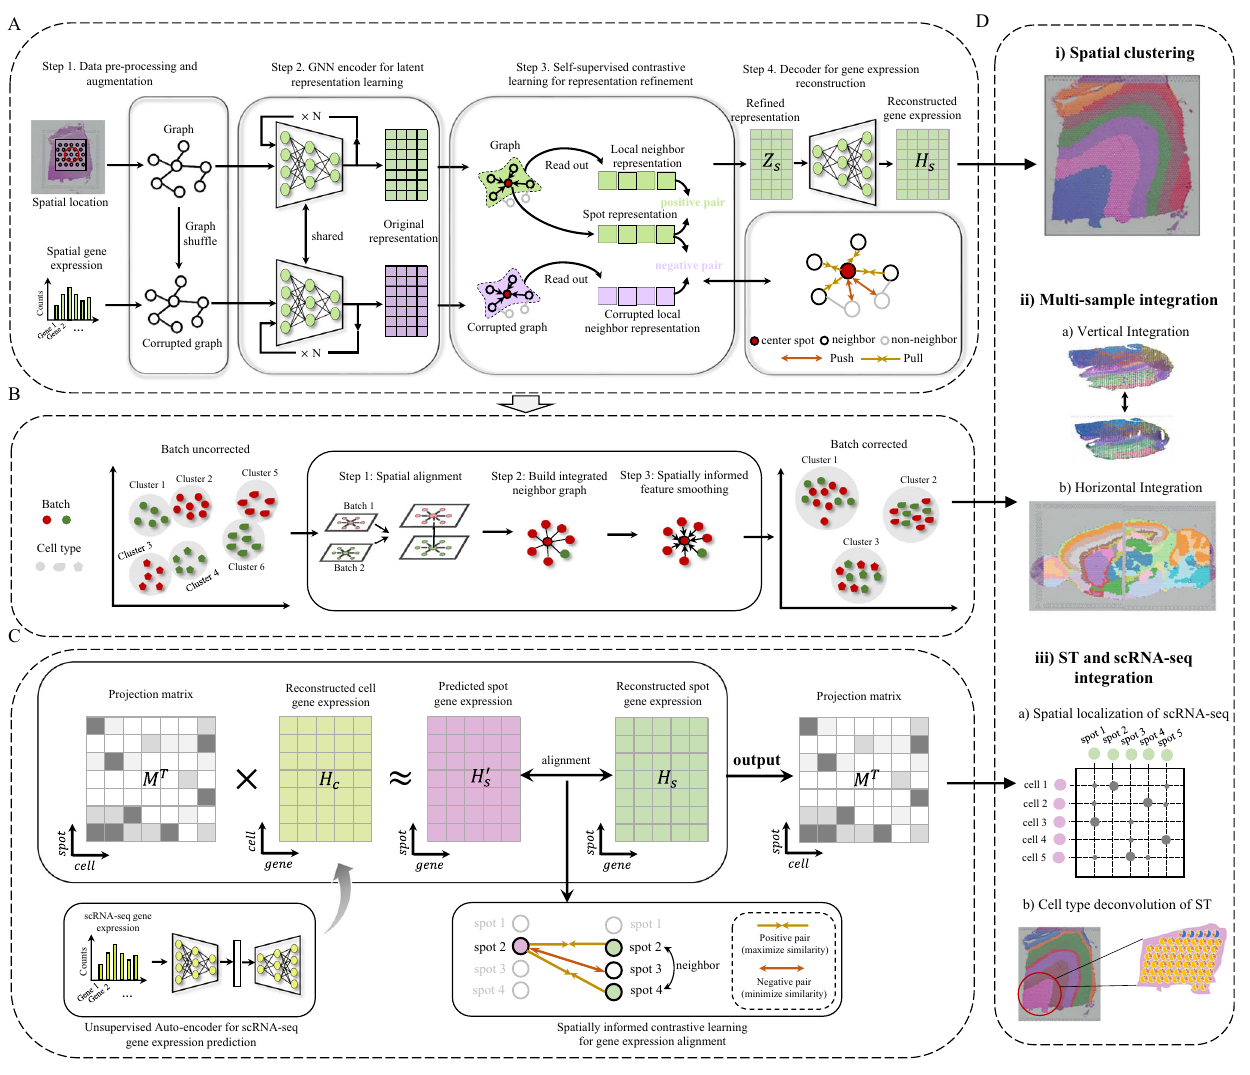
Fig. 1 | Overview of GraphST. A GraphST takes as inputs the preprocessed spatial gene expressions and neighborhood graph constructed using spot coordinates ( x , y ). Latent representation Z s is fi rst learned using our graph self-supervised contrastivelearningtopreservetheinformativefeaturesfromthegeneexpression pro fi les, spatial location information, and local context information. This is then reversed back into the original feature space to reconstruct the gene expression matrix H s . B The analysis work fl ow for spatial batch effect correction by GraphST. The fi rststepistoaligntheH&Eimagesoftwoormoresamples,followedbyshared neighborhood graph construction, where both intra- and inter-sample